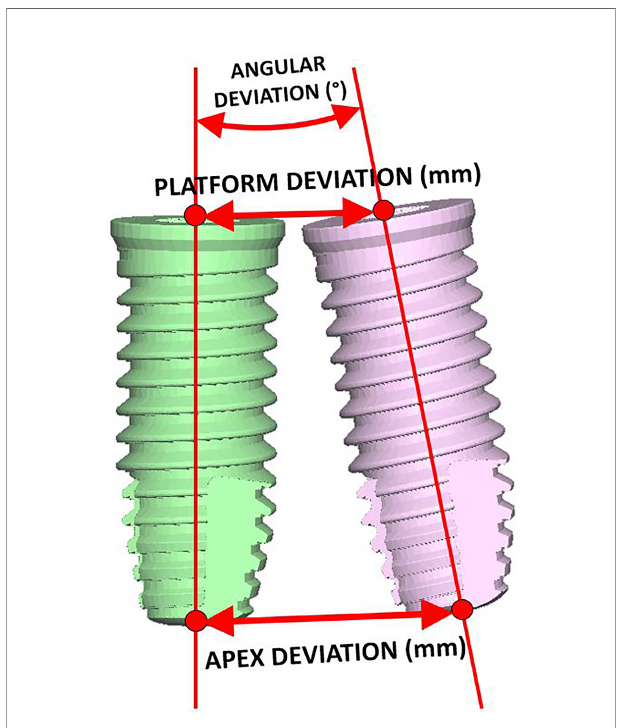
FIGURE 7 | Metrics used to compare the fi nal position of implants with the preoperative virtual surgical